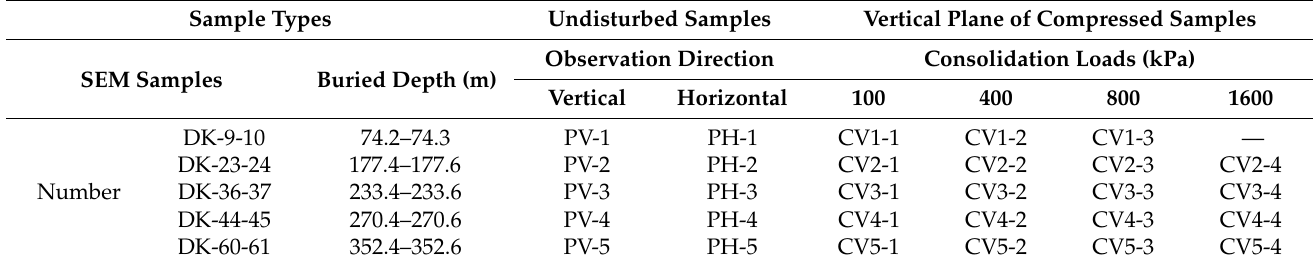
Table 1. Experimental schemes of the consolidation compression and SEM scanning of the samples.